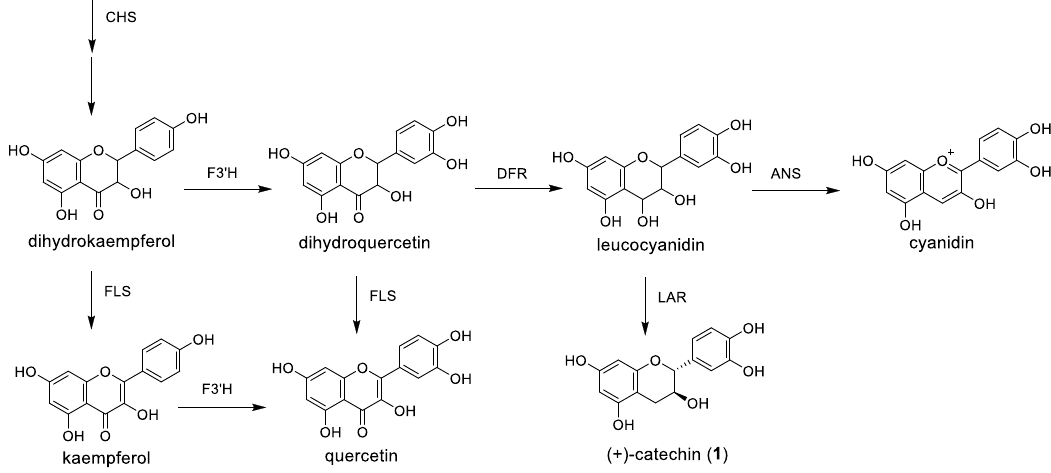
Figure 6. Partial schematic representation of flavonoid biosynthesis. CHS : chalcone synthase; F3′H : flavonoid 3′-hydroxylase; FLS : flavonol synthase; DFR : dihydroflavonol 4-reductase; ANS : anthocyanin synthase; and LAR : leucoanthocyanidin reductase.